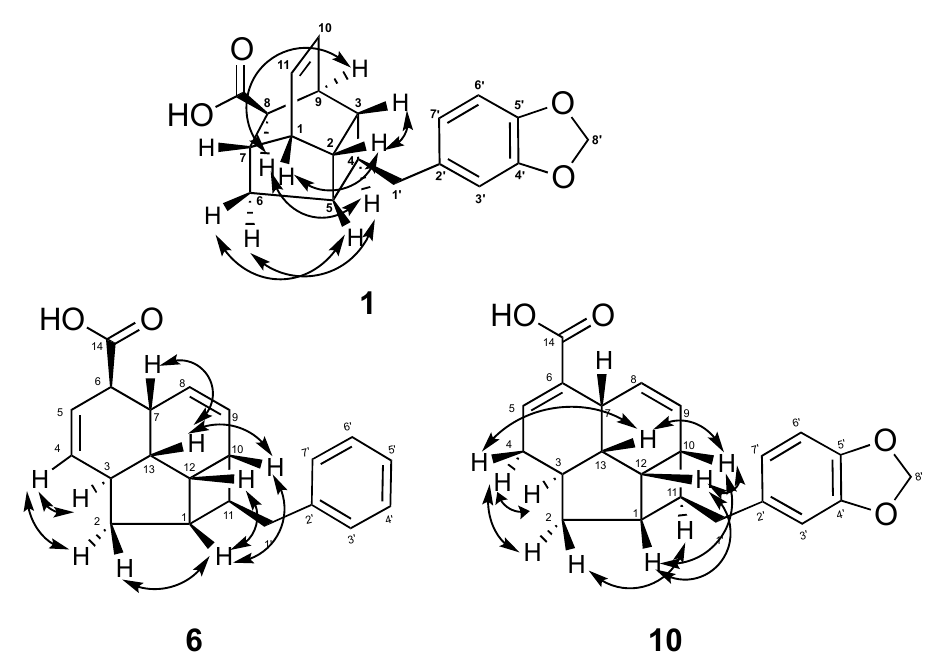
Figure 3. Selected NOESY ( 1 H ↔ 1 H) correlations of 1 , 6 and 10